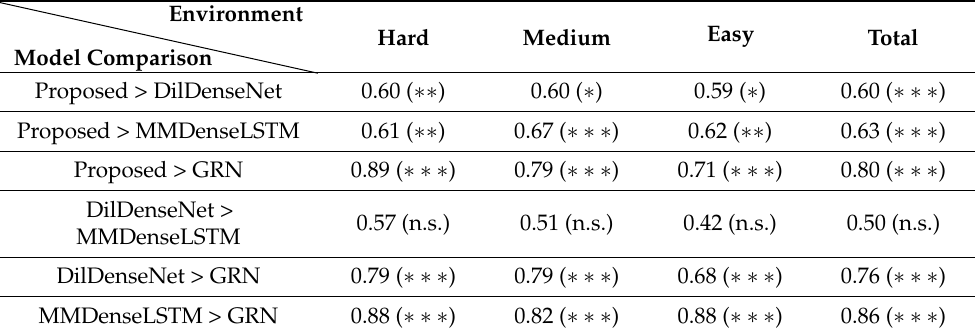
Table 3. Result of subjective listening test. “Hard” indicates an environment that music and noise are mixed at 0 dB, “Medium” mixed at 5 dB, and “Easy” mixed at 10 dB (“n.s.”: not significant, “ ∗ ”: p < 0.05, “ ∗∗ ”: p < 0.01, “ ∗ ∗ ∗ ”: p < 0.001).